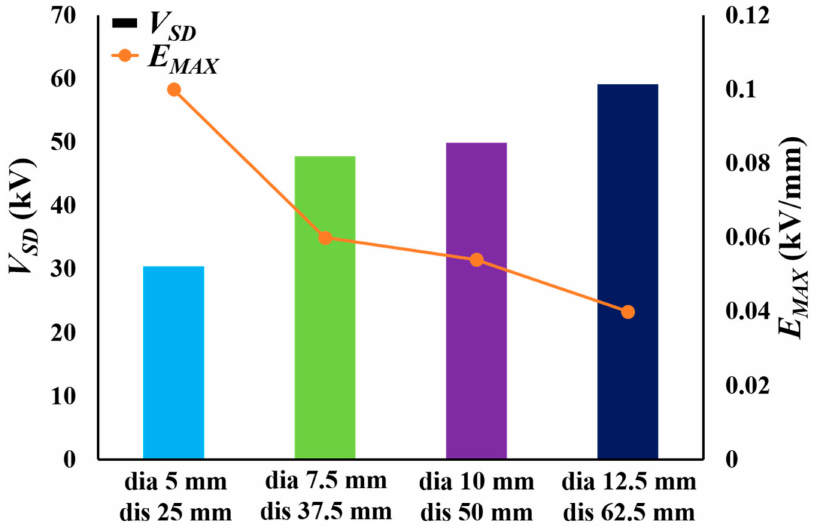
Figure 4. V SD and E MAX, 1 kV of the polymer specimens according to the experimental conditions.